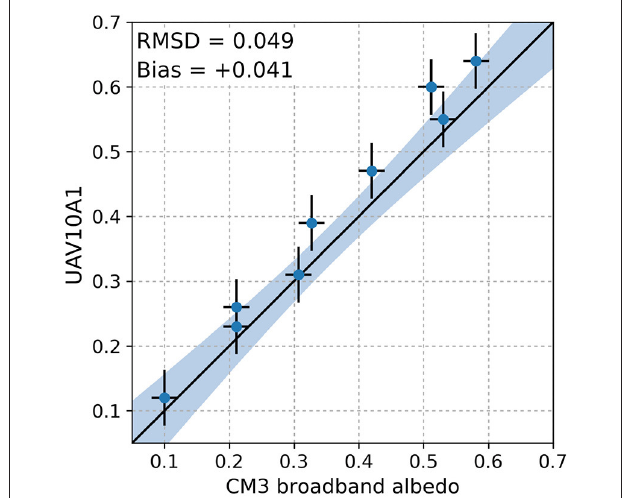
FIGURE 6 | Scatter plot showing relationship between CM3 broadband albedo with albedo of pixels derived from the digital image albedo